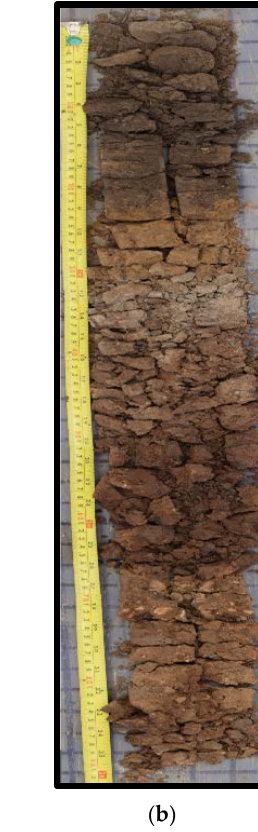
Figure 2. ( a ) Photo of modified post pounder (Deer Fence Canada, Dunrobin, ON, Canada) ( b ) a split core soil profile.